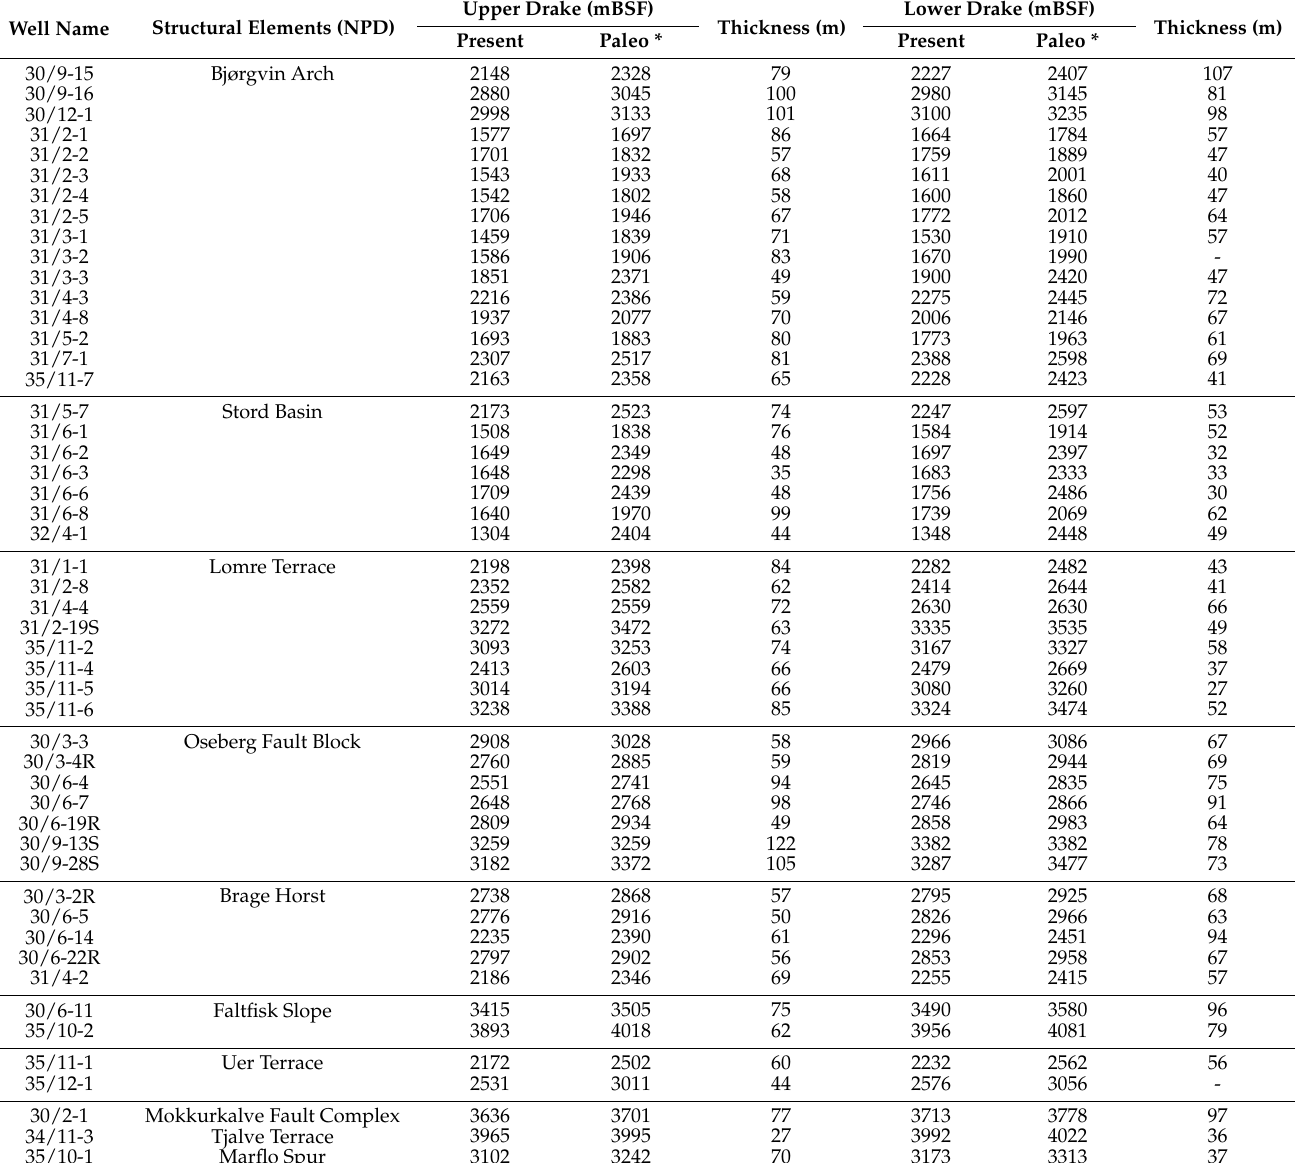
Table 1. Well database with structural elements, caprock present/max. burial depth and